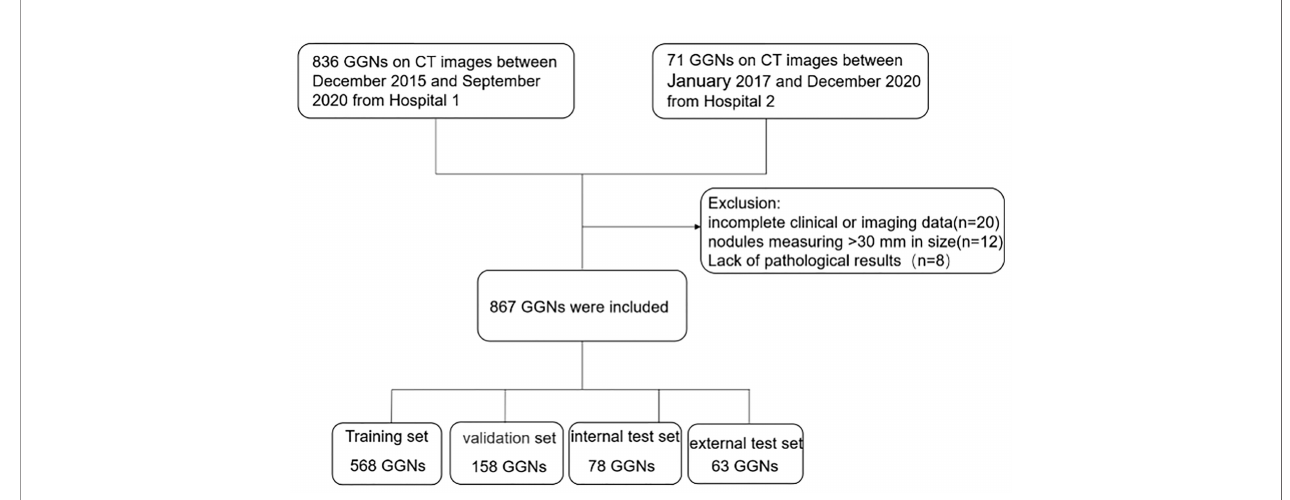
FIGURE 1 | Flowchart of study population. CT, computed tomography; GGN, ground-glass